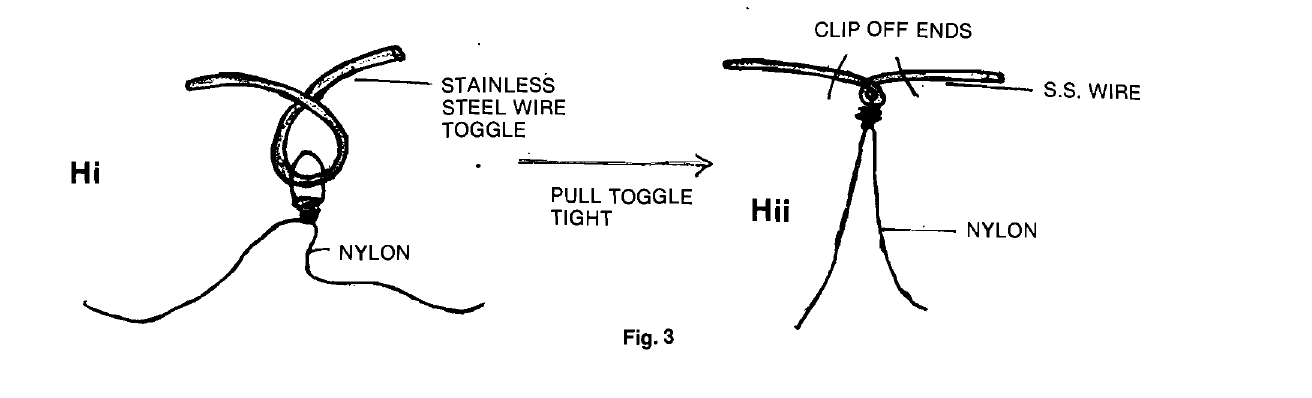
and 30 lb for large